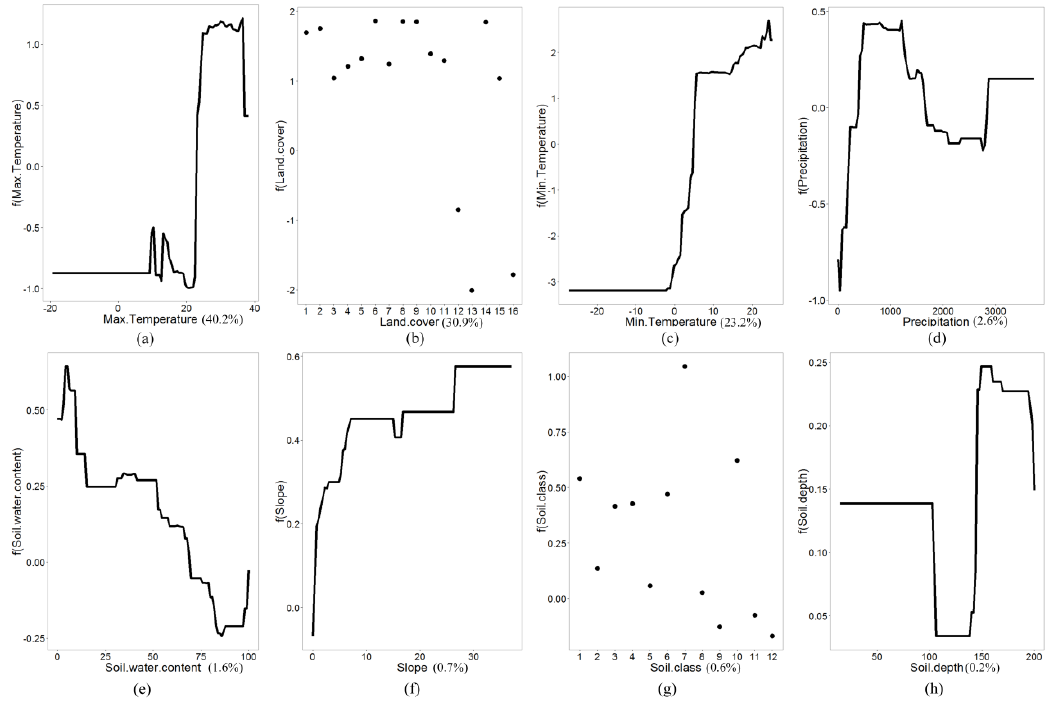
Figure 4. Relative contribution of environmental factors predicting the global distribution of sweet sorghum: ( a ) annual maximum temperature; ( b ) land cover; ( c ) annual minimum temperature; ( d ) mean annual precipitation; ( e ) soil water content; ( f ) slope; ( g ) soil class; ( h ) effective soil depth.